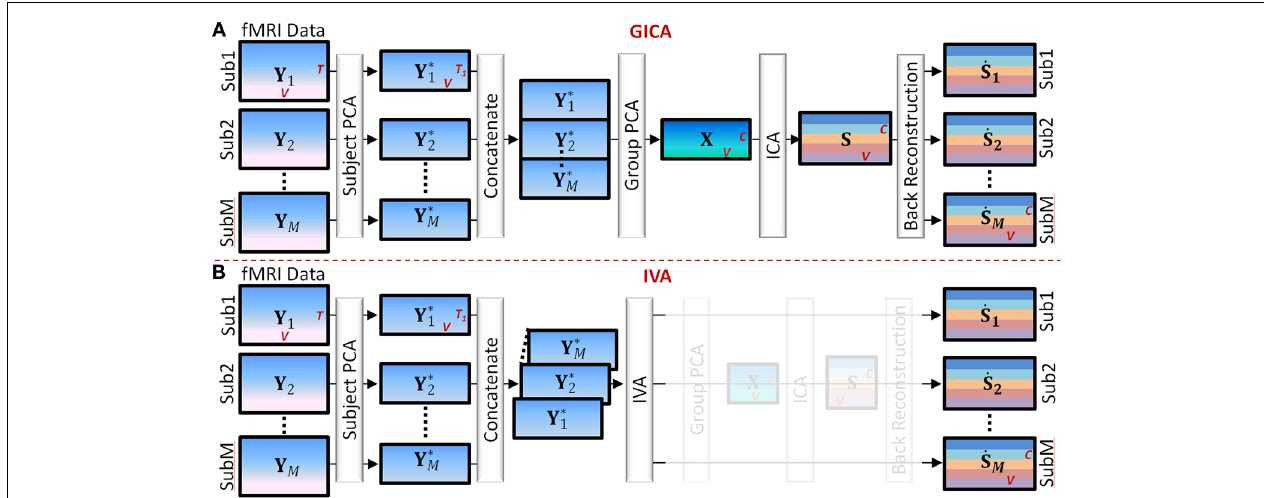
FIGURE 1 | Main Steps of GICA and IVA (see Section GICA vs. IVA for more details). (A) GICA: (i) subject level principal component